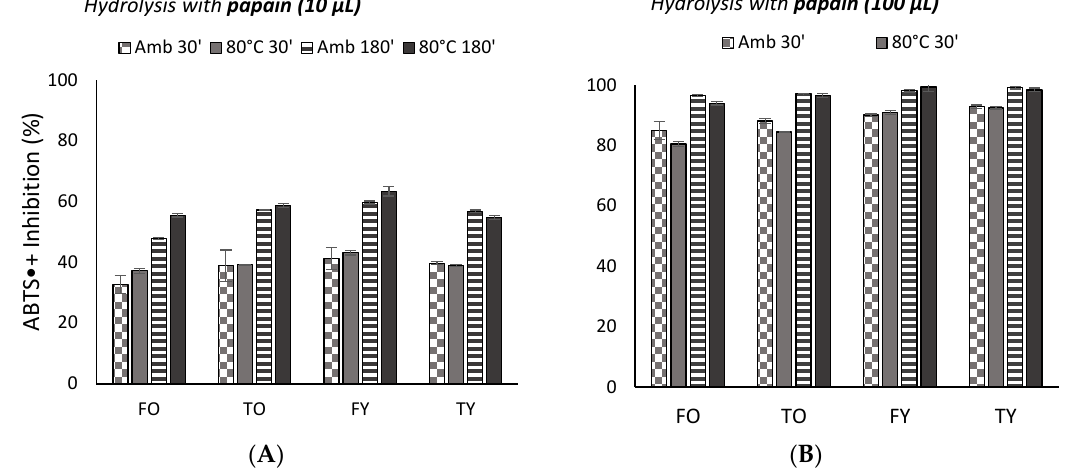
Figure 5. ABTS•+ inhibition (%) by collagen peptides solutions (<3000 Da) obtained through the most effective enzyme, i.e., papain, for 10 µL ( A ) and 100 µL peptides solutions ( B ), at ambient temperature and 80 °C, and after 30 ant 180 min of incubation. FO = old femur, 10 years; TO = old tibia, 10 years; FY = young femur, 4.5 years; TY = young tibia, 4.5 years.